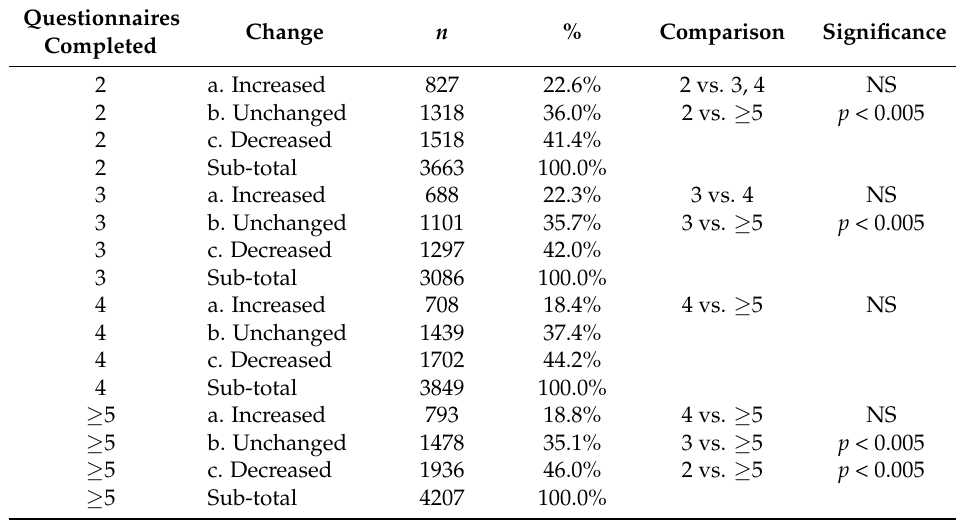
Figure 1. Confidence reported as a function of the number of symptoms questionnaires completed. Decreased confidence reported by women who originally reported confidence (CS > 0). Table 6. Longitudinal stability as a function of the number of symptoms questionnaires completed (CS > 0).